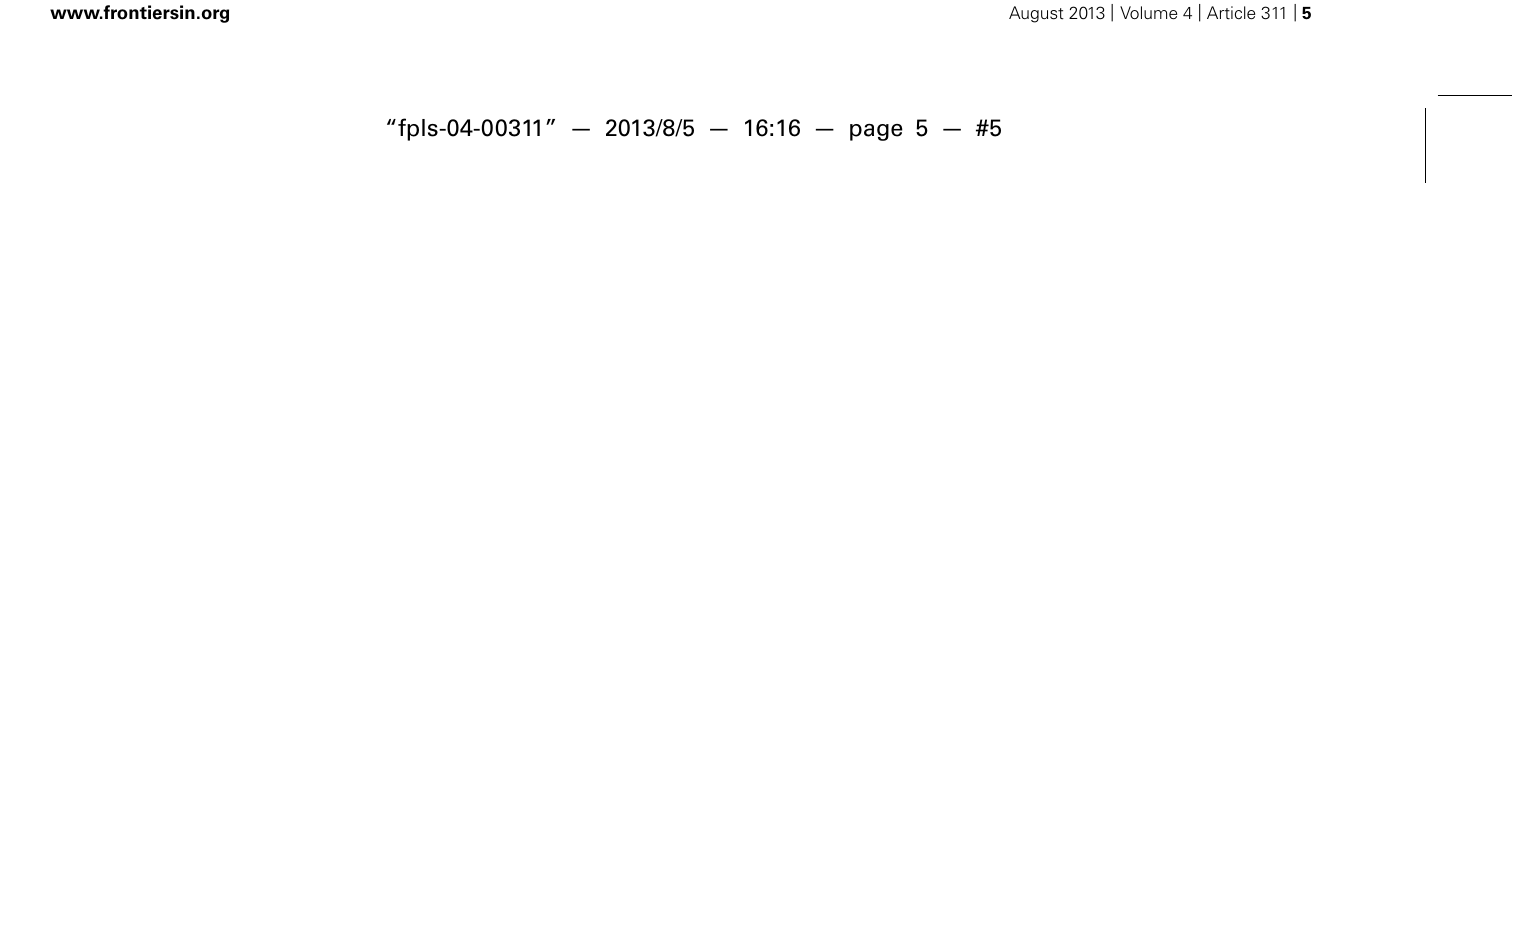
FIGURE 4 | Expression ofVSFP2s from the Ubi-10 promoter and targeting to nuclear membrane in root cells. (A–D) When driven by the ubiquitin-10 promoter, the FRET pair inVSFP2.3 (mCerulean and citrine) produces strong and uniform signals at the plasma membrane of cells in the root maturation zone (A,B) .WhenWPP is fused to theVSFP2.3 construct, fluorescence is highly concentrated at the nuclear membrane in cells of the maturation zone and in root hair cells (C,D , + WPP) . (E–H) Similar results are obtained withVSFP2.4 under the control of the ubiquitin-10 promoter (FRET